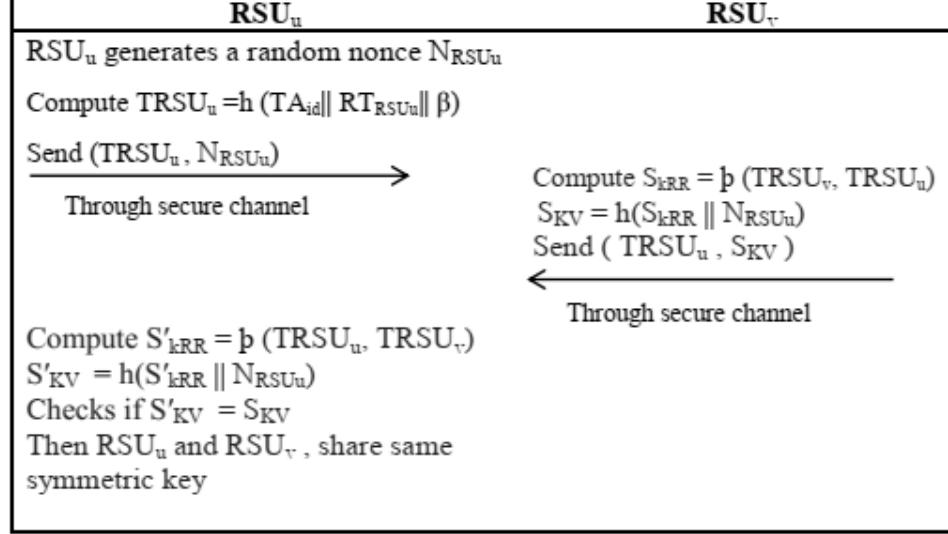
Figure 6. RSU2RSU Key Establishment